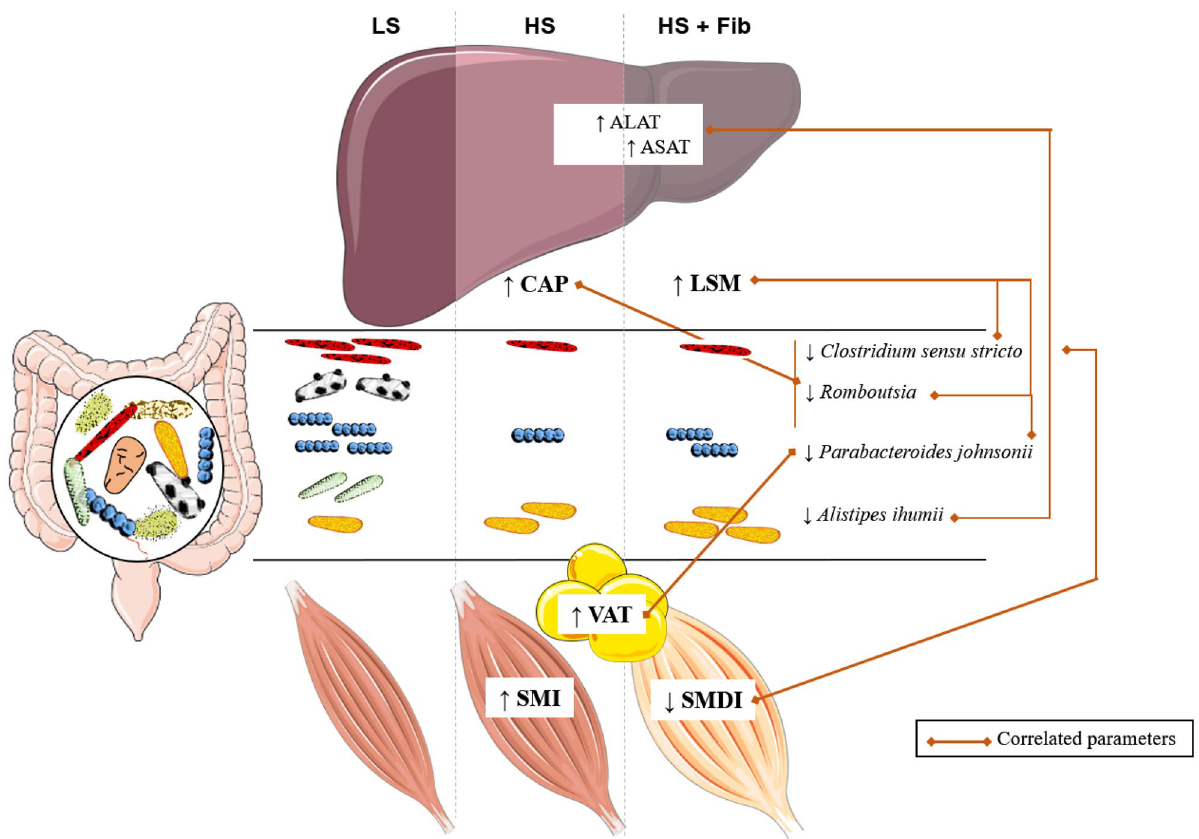
Figure 4. Muscle dysfunction, specific gut microbiota characteristics, and visceral adiposity correlate to the severity of metabolic associated fatty liver disorders (MAFLD) in obese patients. CAP, controlled attenuation parameter; LS, low degree of steatosis; HS, high degree of steatosis; HS + Fib, high degree of steatosis and fibrosis; LSM, liver stiffness measurement; SMI, skeletal muscle index; SMDI, skeletal muscle density index; VAT, visceral adipose tissue. The figure was produced using Servier Medical Art (www.servi